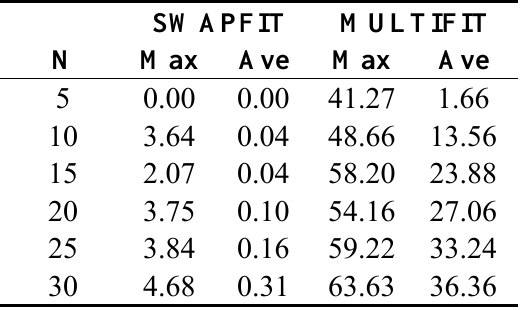
Table 4. Summary of algorithm performance (% deviation from best know lower